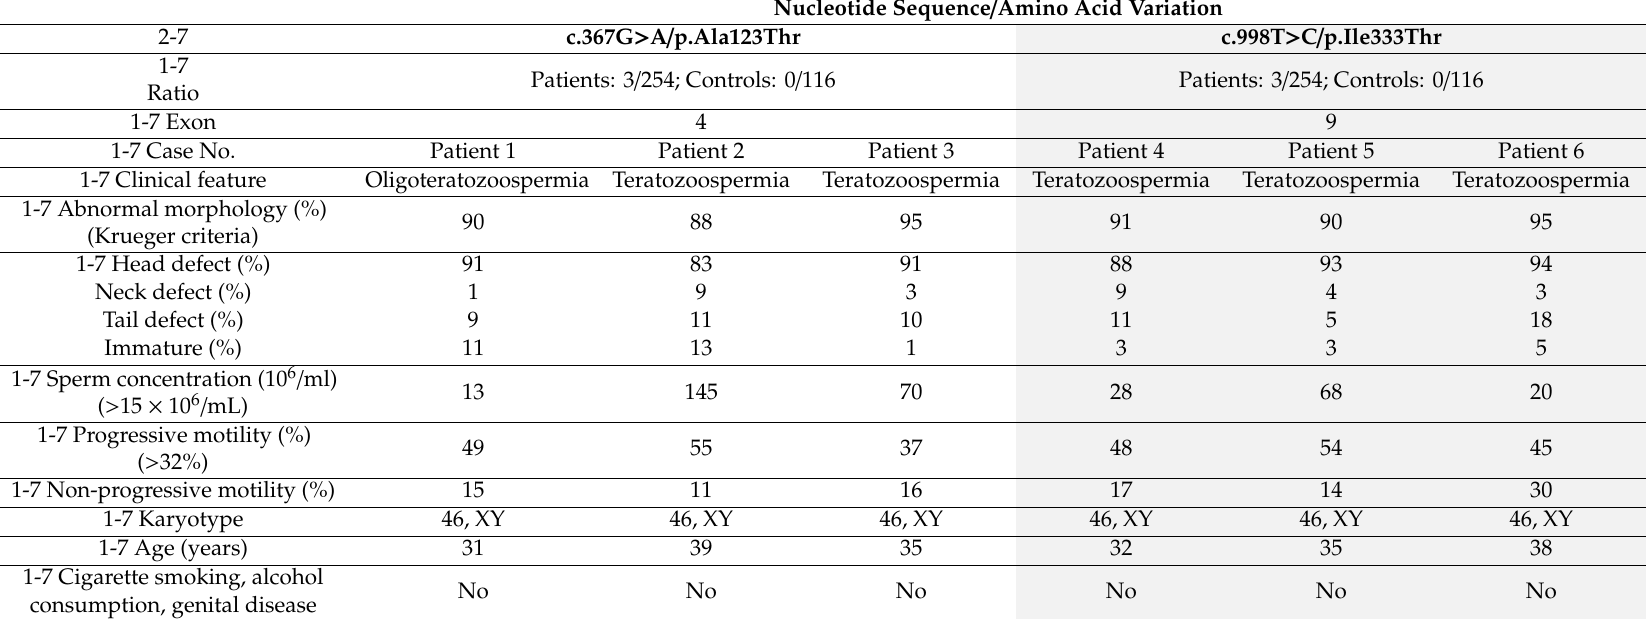
Table 1. Clinical characteristics of infertile patients with c.367G > A / p.Ala123Thr and c.998T > C / p.Ile333Thr SEPTIN14